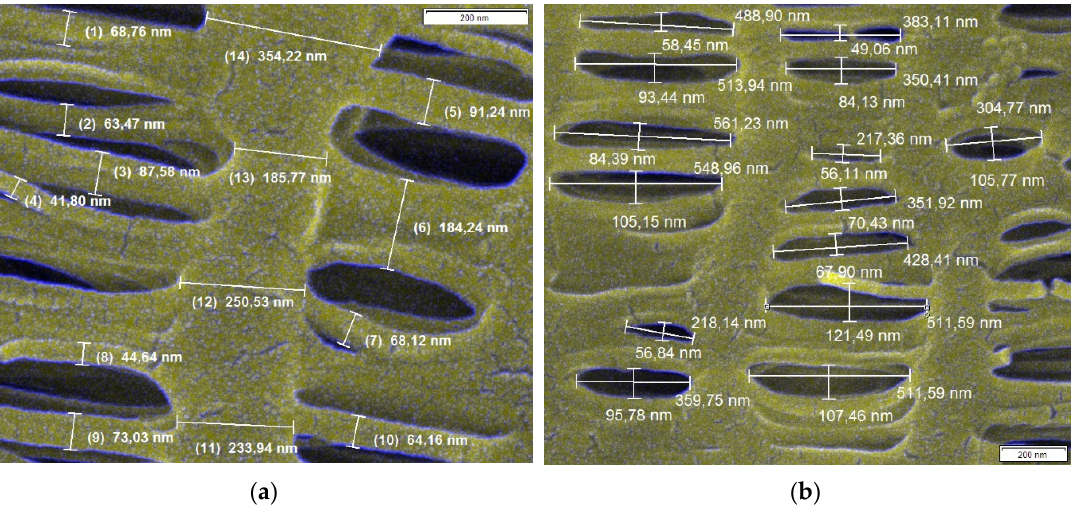
Figure 4. Evaluation of collector diameter ( a ) and pore size ( b ) from SEM images using Stream Motion software. Table 1. Parameters of HFM pore structure and conditions used for calculations.